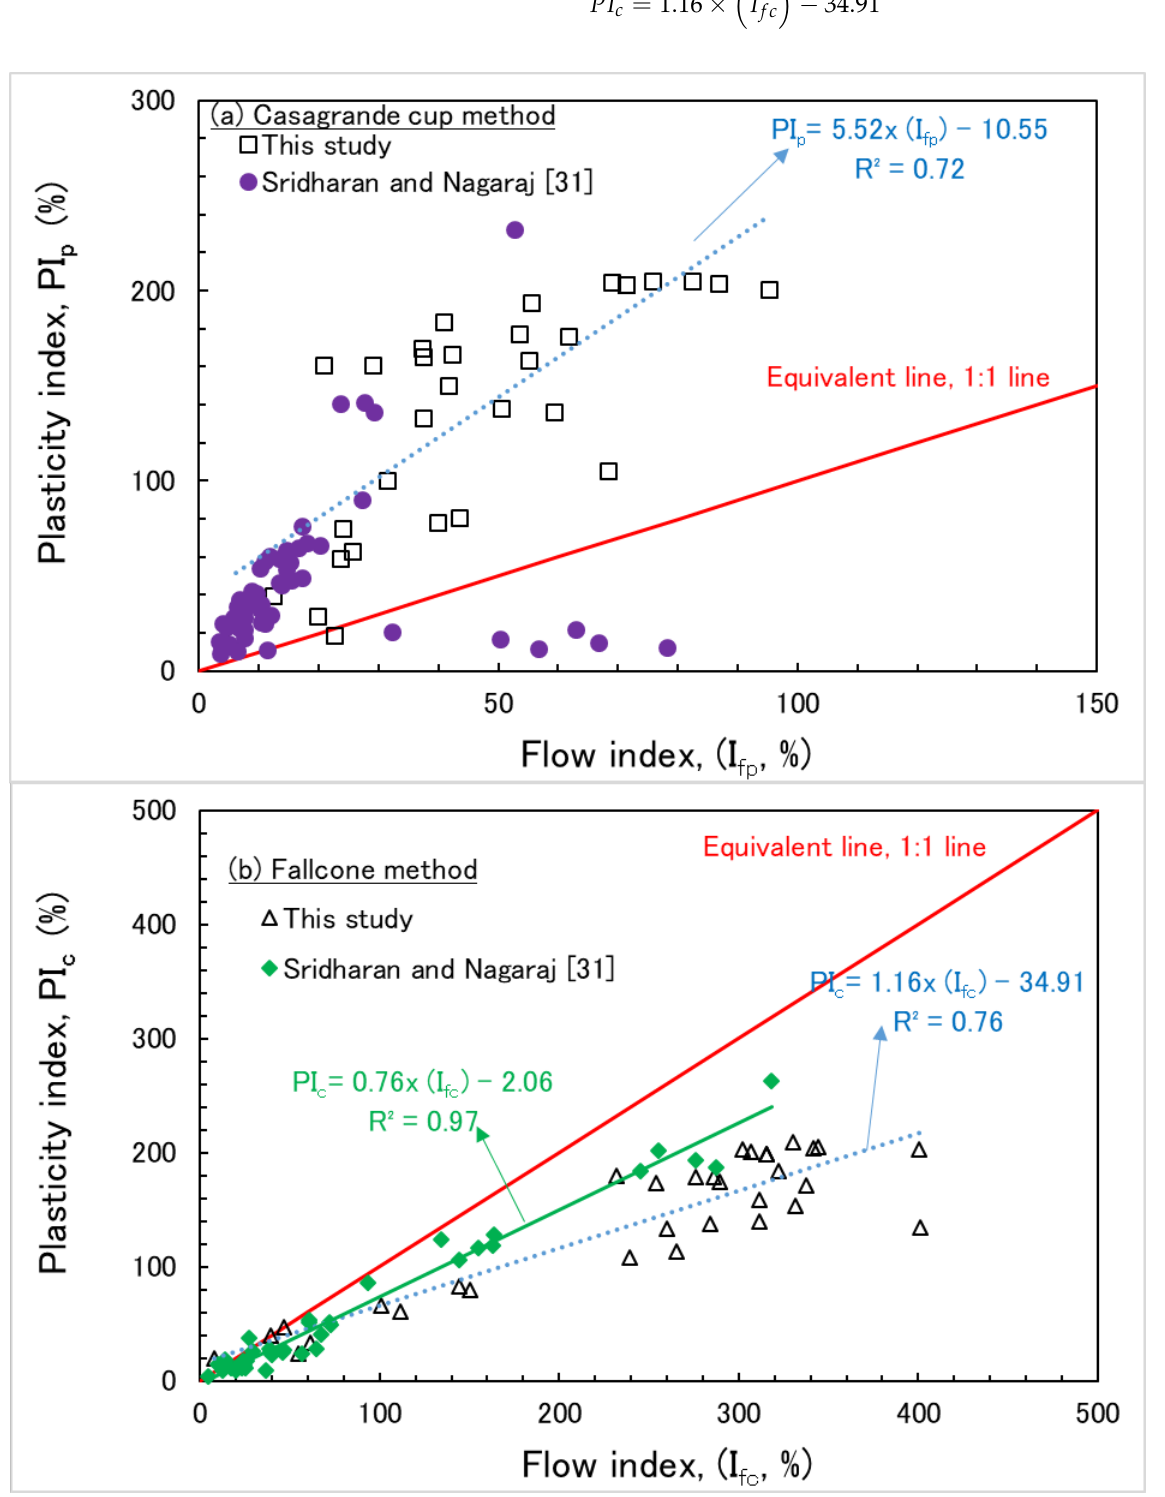
Figure 8. Relationship between flow index and plasticity index using the ( a ) Casagrande cup method and the ( b ) Fall cone